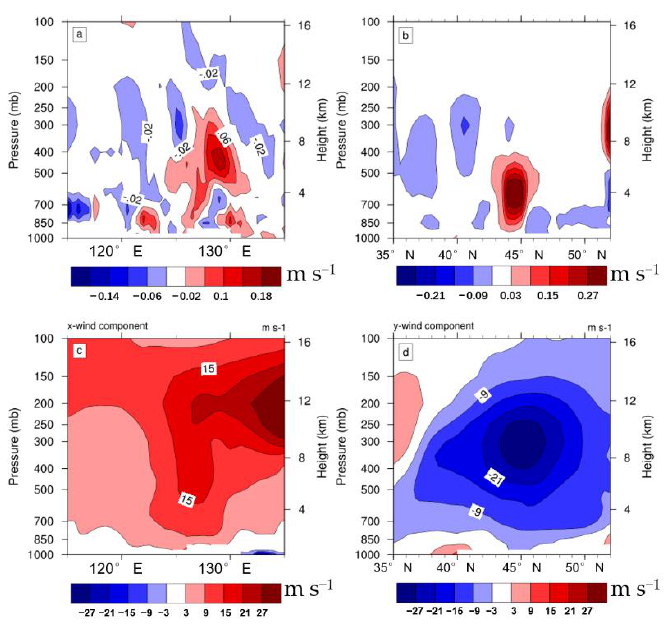
Figure 11. Vertical cross-section of w (shaded; m · s − 1 ) along 42.5 ◦ N ( a ) and 124.0 ◦ E ( b ); vertical cross-section of u (shaded; m · s − 1 ) along 42.5 ◦ N ( c ); and v (shaded; m · s − 1 ) along 124.0 ◦ E ( d ) at 17:00 LST in Domain 2 on 3 July 2019.